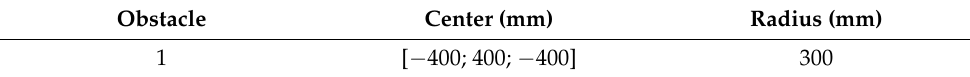
Table 3. Obstacle Setting. Obstacle